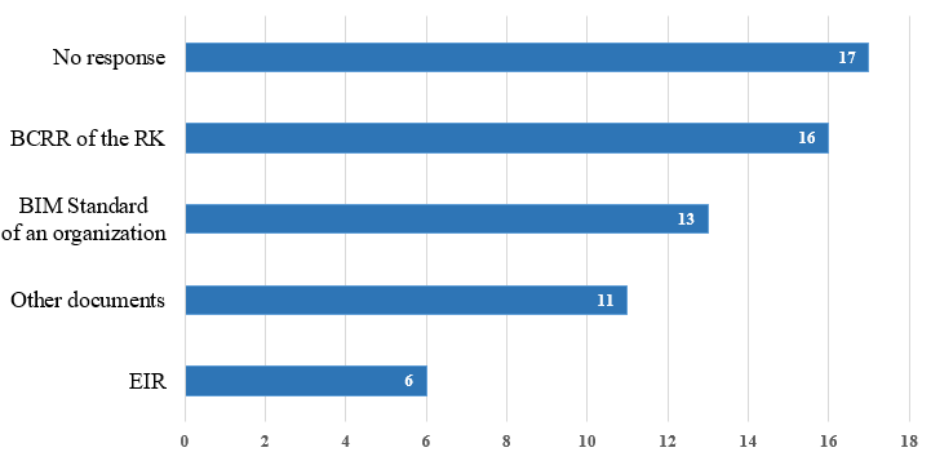
Figure 5. The regulatory documents in construction companies and project design organizations that control the work on BIM technology.